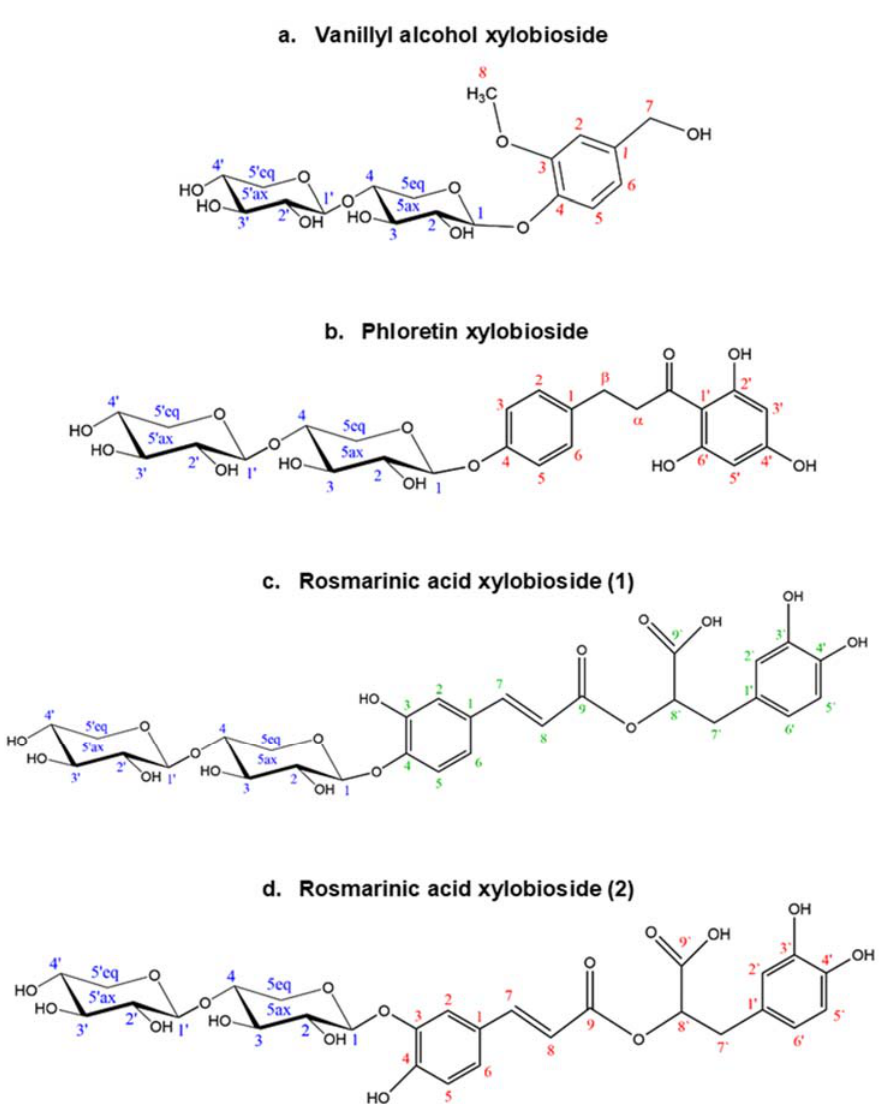
Figure 6. Structures deduced from NMR analysis of the glycosides of ( a ) vanillyl alcohol, ( b ) phloretin, and ( c , d ) rosmarinic acid. Every C atom in the molecules is numbered to clarify the identification of the signals.